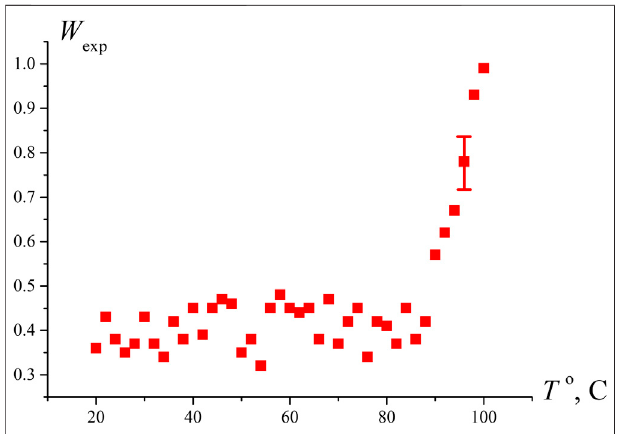
FIGURE 3 | Dependence of the probability of optical breakdown W exp vs. the temperature of water in an open cell. It is seen that the density of the breakdown centers increases substantially near the boiling